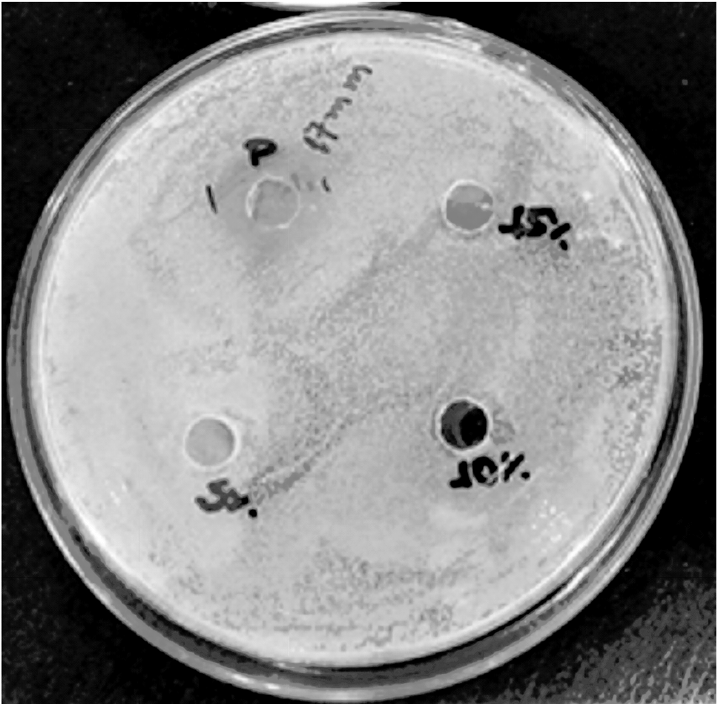
Figure 6. Halo of inhibition of manuka honey against Staphylococcus aureus (P = pure honey, showing 495 17-mm diameter of inhibition). Materials 2019 , 10 , x FOR PEER REVIEW